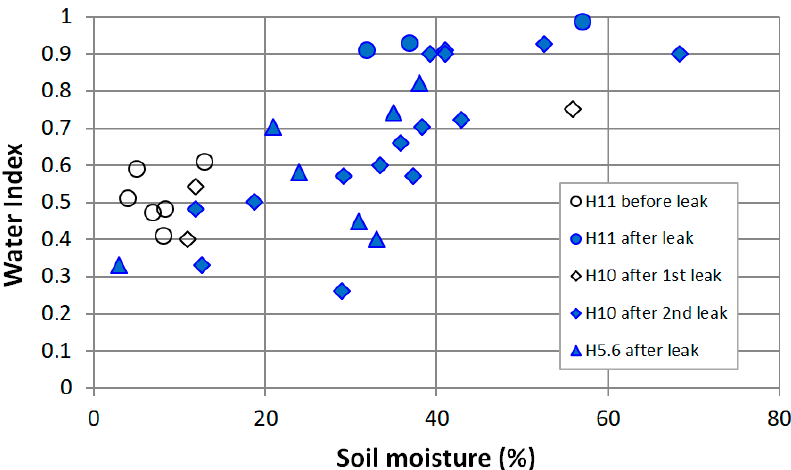
Figure 16. Correlation between the local Water Index inferred from the multispectral images obtained with the UAV and the soil moisture measured with a TDR probe at distances ranging from 0 to 30 m from the artificial leaks at hydrants H10, H11 and H5.6 (Figures 11–14 and 15a). The acoustic campaign in Monte Novo located another leak by sonic correlation at 26 m from an air valve. Close to it, the WI image showed a significant contrast over an elongated area starting from the air valve and extending downhill in the southeast direction (yellow ellipse in Figure 17a). A similar pattern, yet shorter, was observed in the same field (blue ellipse in Figure 17a). During the next flight on 11 September 2019, the first pattern shrunk whereas the second one appeared more elongated (Figure 17b). The second anomaly was ruled out as a leak because its location was mainly north, i.e., uphill, of the pipeline (Figure 17a). A ground-truth measurement on 10 September 2019, showed that the mean moisture level was about 13% along the first WI-anomaly while reaching up to 23% locally (yellow ellipse in Figure 17b), whereas it was only about 7% a few meters away. Sparse green vegetation (short grass) could be seen along the WI anomaly, as opposed to dry vegetation away from it (Figure